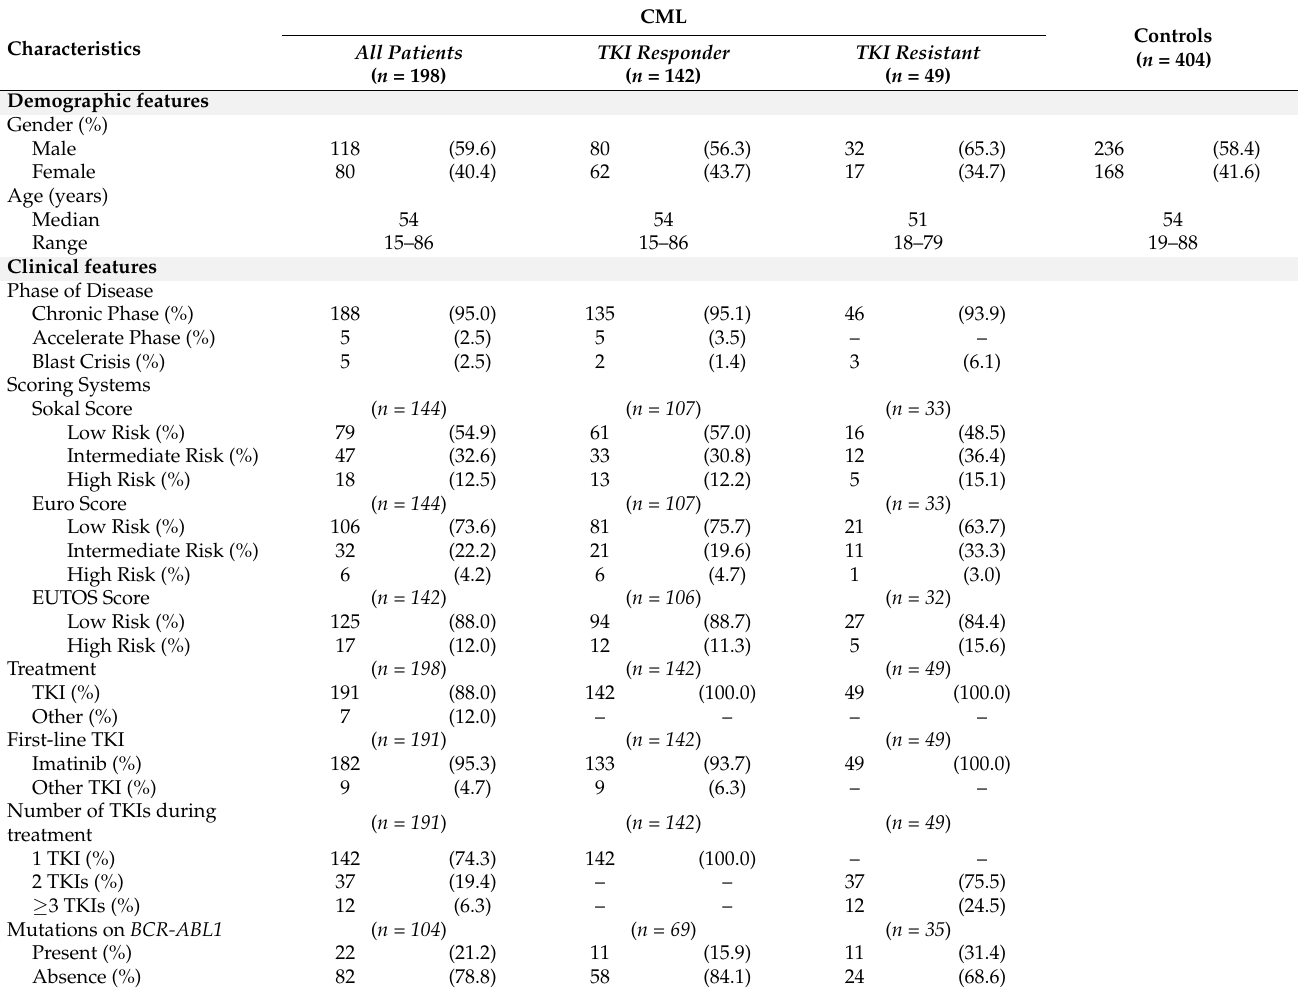
Table 1. Demographic and clinical characteristics of patients and